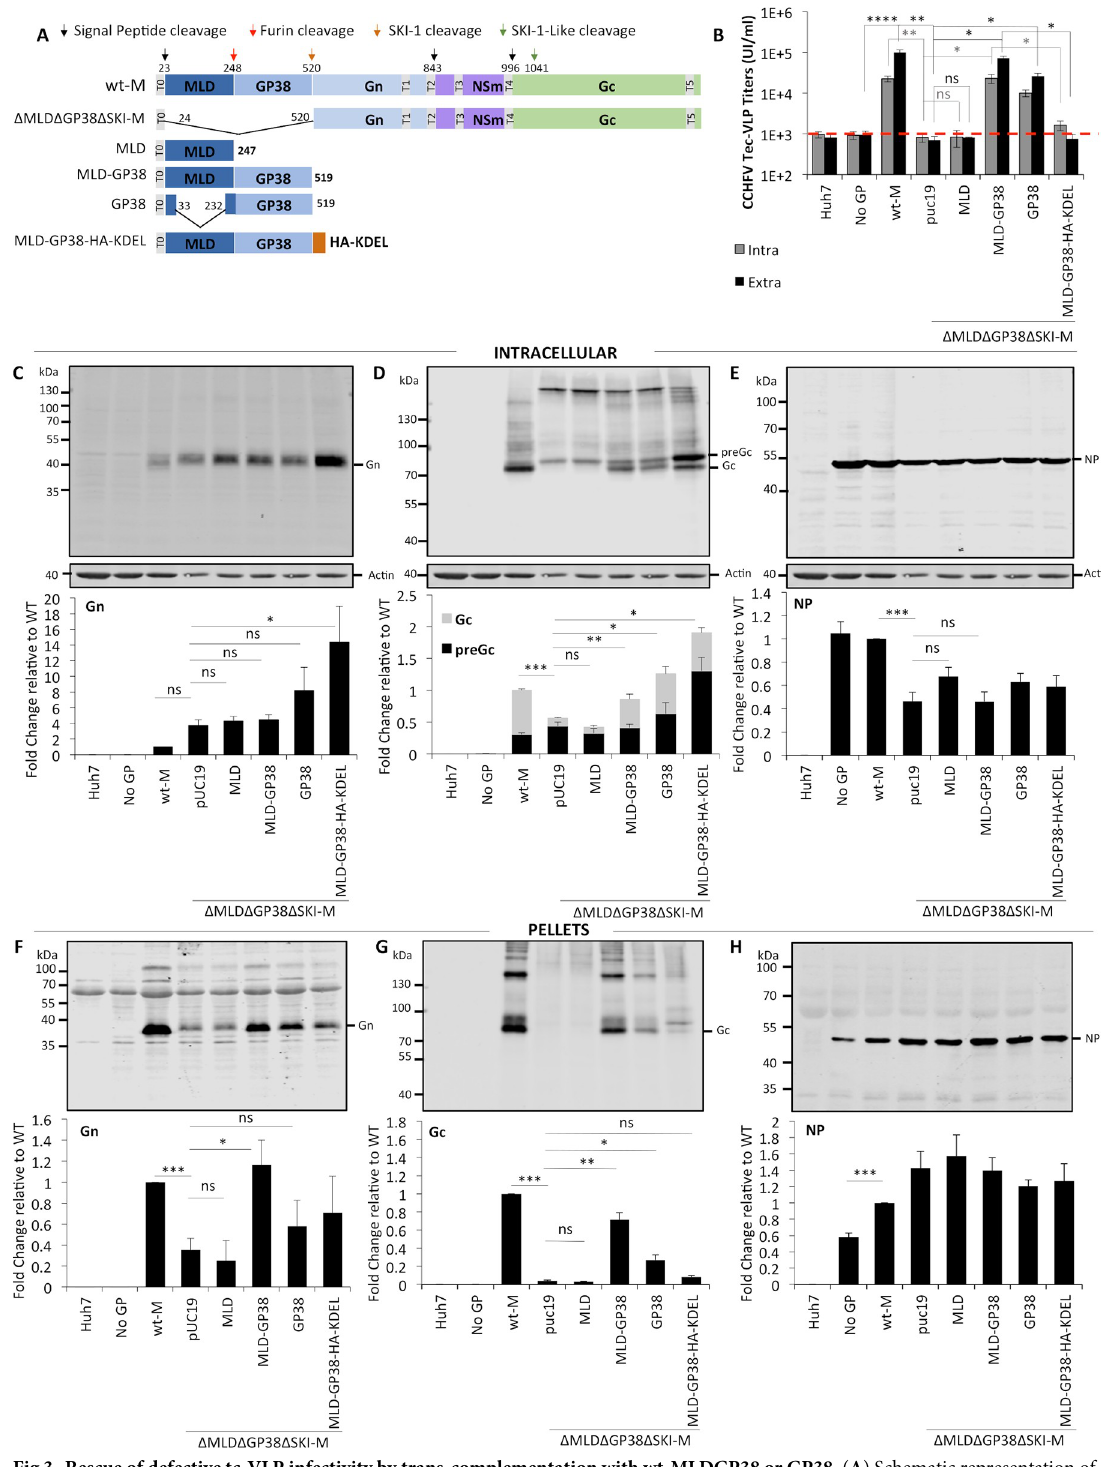
Fig 3. Rescue of defective tc-VLP infectivity by trans-complementation with wt-MLDGP38 or GP38. ( A ) Schematic representation of wt-M, Δ MLD Δ GP38 Δ SKI-M segment, MLD, MLD-GP38, MLD-GP38-KDEL and GP38 expressing constructs. CCHFV tc-VLPs were generated using constructs encoding either wt-M polyprotein, or Δ MLD Δ GP38 Δ SKI-M deletion mutant complemented in trans with either pUC19, or with MLD, MLD-GP38, MLD-GP38-HA-KDEL and GP38 expression vectors. Infectivity, CCHFV protein expression and tc-VLP secretion were analyzed at 72h post-transfection. ( B ) Clarified supernatants were inoculated on L and N pre-transfected Huh7 cells and infectious titers were determined by FACS 24h post-infection. ( C-E ) Intracellular levels of CCHFV proteins expression and processing. Cell lysates of tc-VLP-producing cells were analyzed by Western blotting as described in Fig 1. Representative western blot